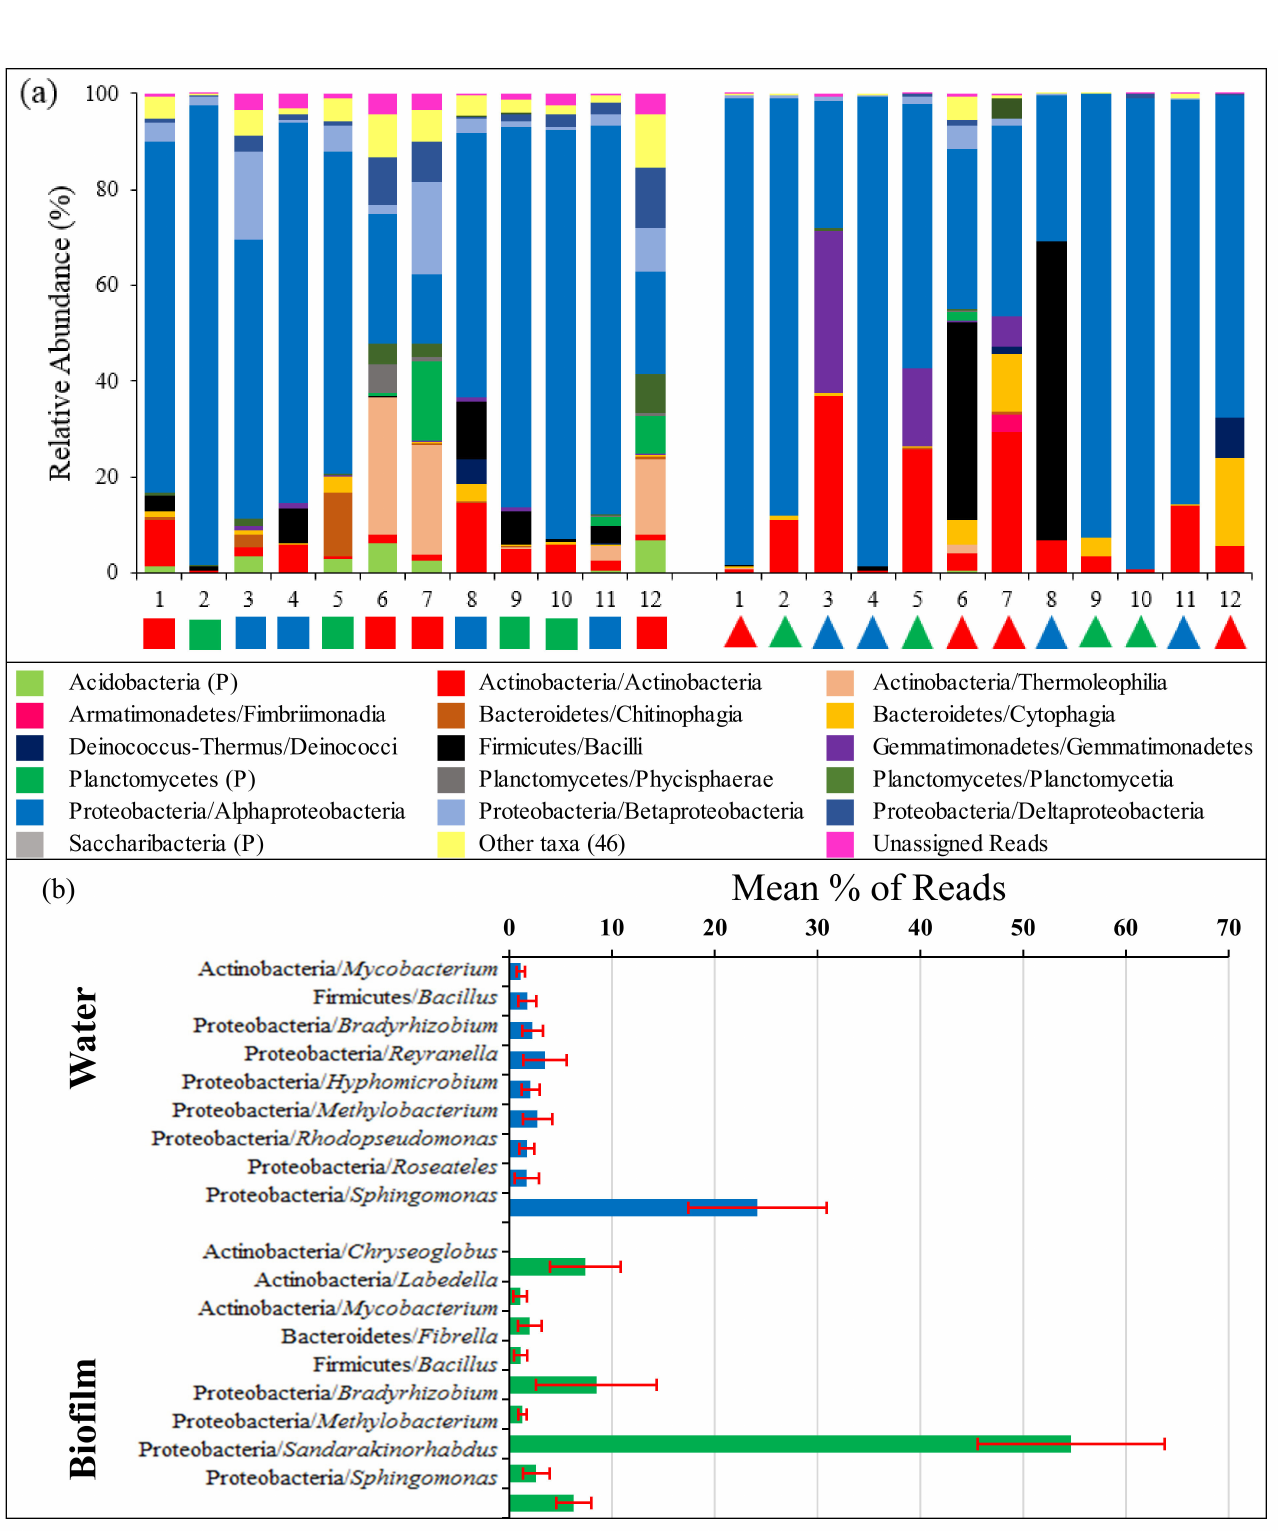
Figure 3. Variation in bacterial composition between drinking water (squares) and biofilm (triangles) and between individual fountains and fountain types: ( a ) variation at class level where fountain types are shown in color: type A (green), type B (blue) and type C (red); ( b ) variation at genus level for the most abundant taxa for water ( n = 12 fountains) and biofilm ( n = 12 fountains). Vertical axis labels represent phylum/genus and error bars indicate standard